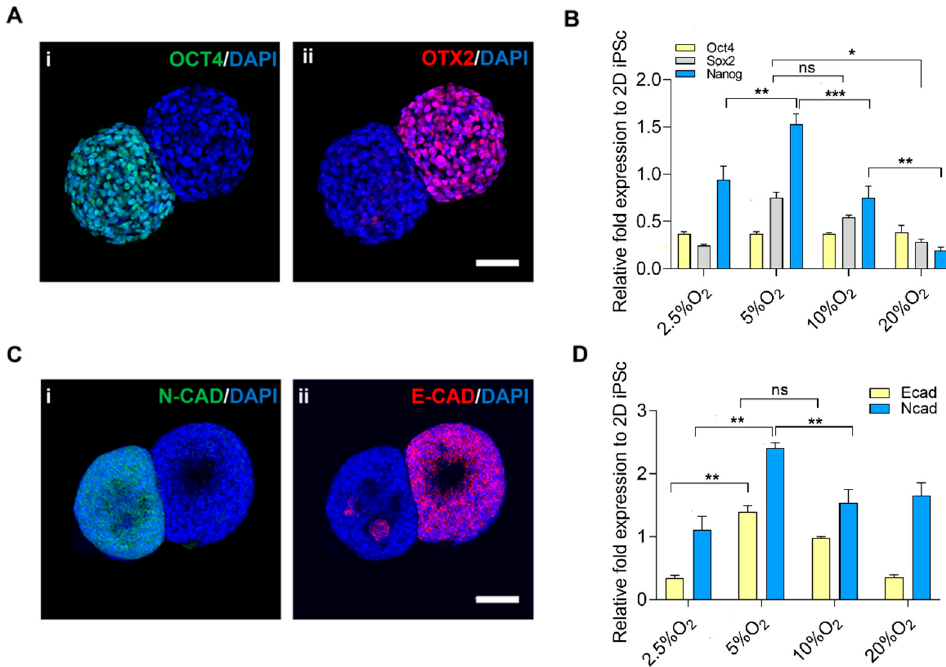
Figure 4. Exit from pluripotency and epithelial–mesenchymal transition. ( A ) Localized expression of the pluripotent marker by the presence of OCT4 and OTX2, scale bar: 50 µm. ( B ) Gene expression of pluripotent markers, corresponding to oxygen. ( C ) Exit from pluripotency and EMT (E-cadherin to N-cadherin), scale bar: 50 µm. ( D ) Gene expression of EMT. Statistical analysis was performed with one-way ANOVA/Tukey’s test. * p < 0.05, ** p < 0.01, *** p < 0.001; ns = non-significant with N = 3 sets of independent experiments.